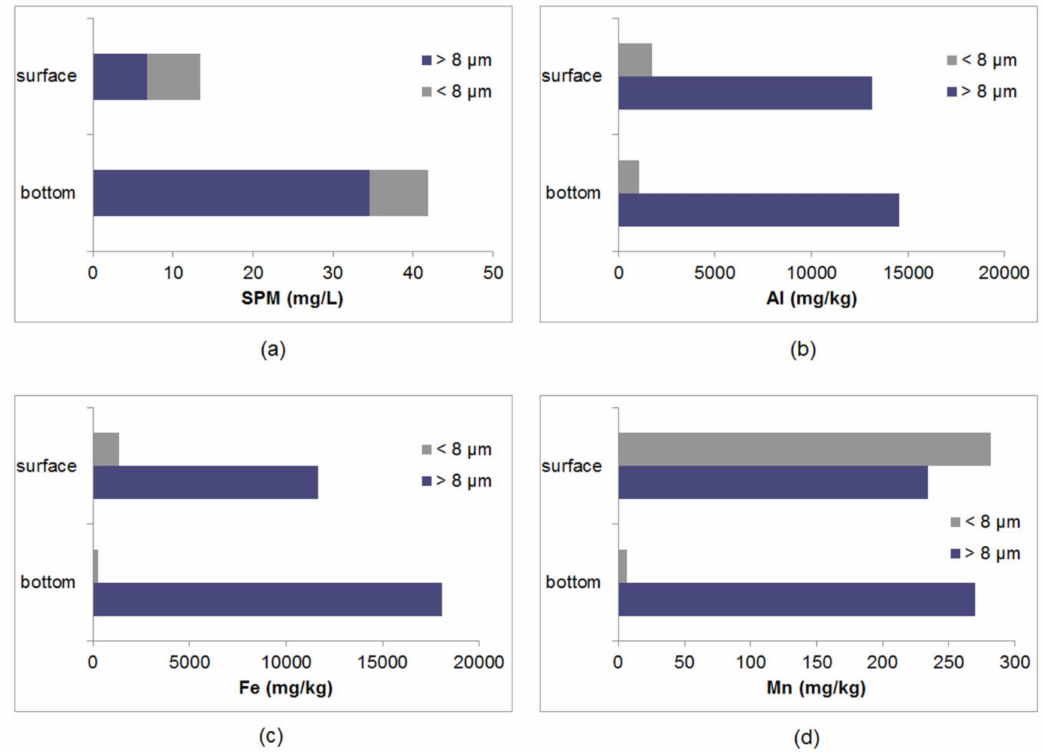
Figure 4. Concentrations of ( a ) SPM, and ( b ) Al, ( c ) Fe, and ( d ) Mn (w / w) contents of particulate solids with diameter d < 8 µ m and d > 8 µ m in the brackish surface and the saline bottom water layer of station